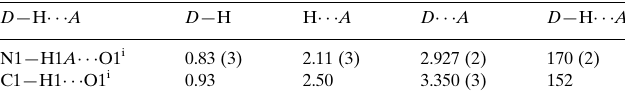
Hydrogen-bond geometry (A˚ , (cid:2)